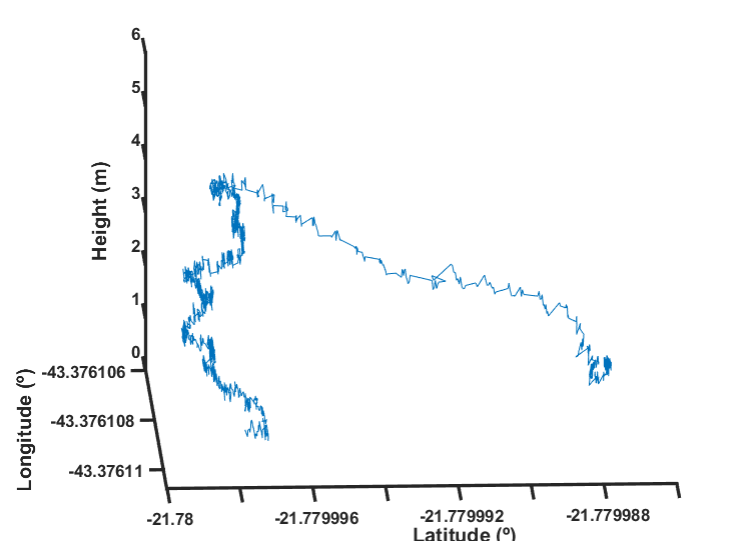
Figure 22. Height response without fuzzy